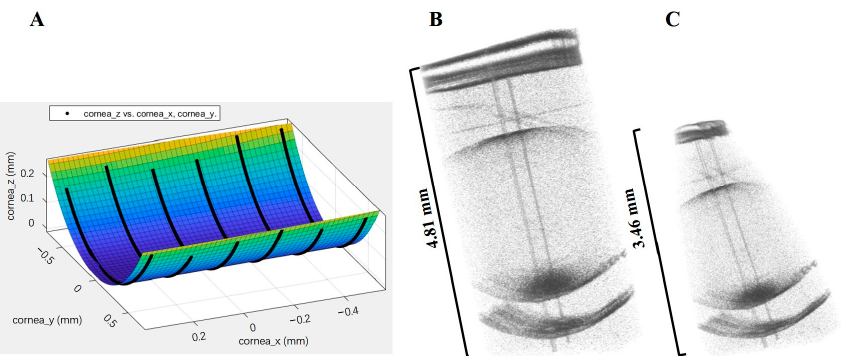
Figure 4. Schematic diagram of the fitting result: ( A ) The fitting function of the anterior surface of the cornea; ( B ) Stereograms of the whole eye before correction; ( C ) Results of the correction of